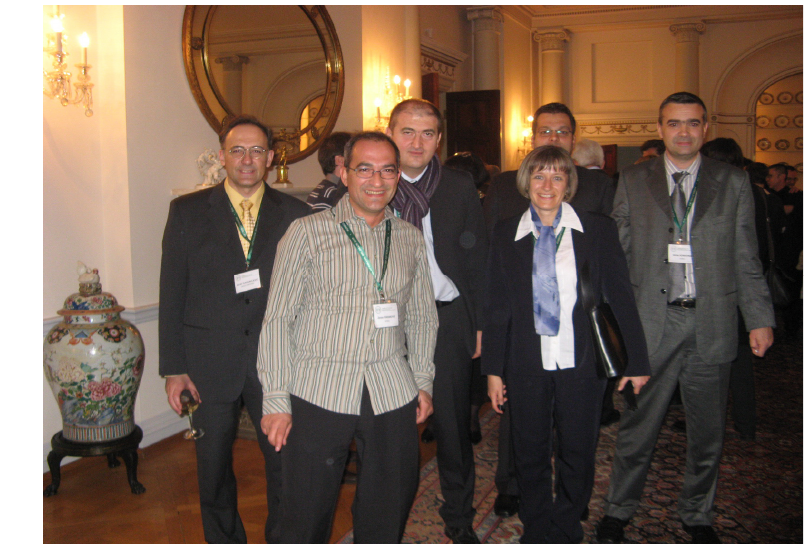
Figure 1 – AvH fellows from Serbia at the Kolleg 2010 in Belgrade (Zoran Radakovic, Goran Vladisavljevic, Srecko Stopic, Ana Kostov, Mirko Komatina) Slika 1 – Stipendisti Humboltove Fondacije iz Srbije tokom skupa Koleg 2010. godine u Beogradu (Zoran Radakovi ć , Goran Vladisavljevi ć , Sre ć ko Stopi ć , Ana Kostov, Mirko